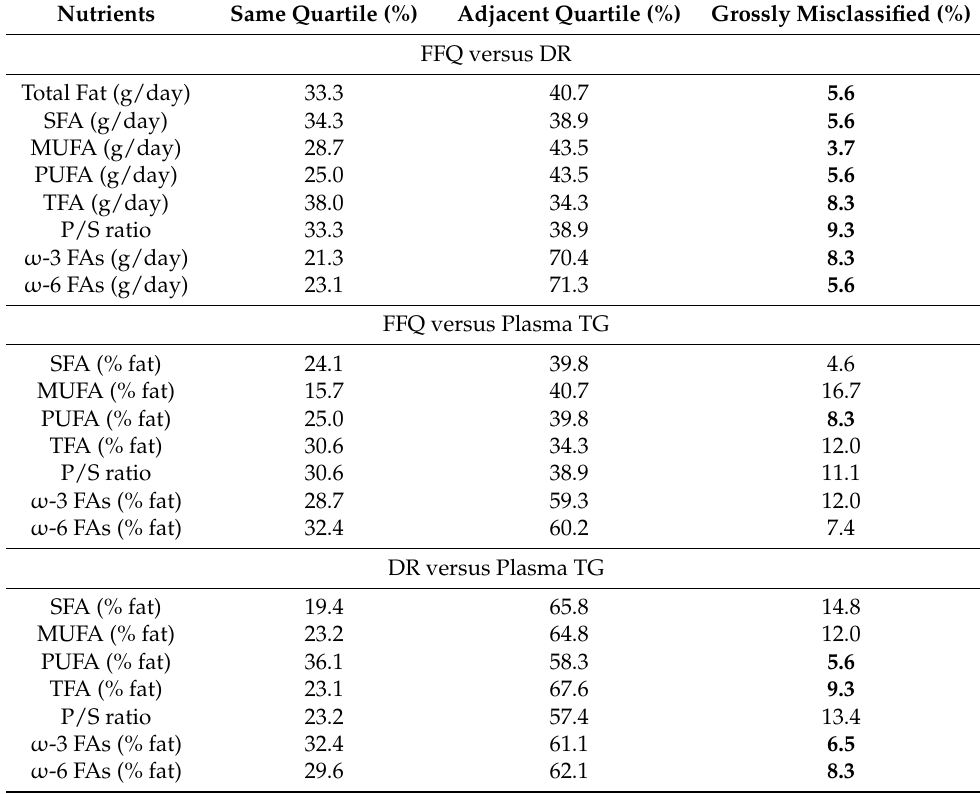
Table 4. Cross-quartile classifications for total fat and fatty acid profile comparisons between FFQ, DR and plasma TG.